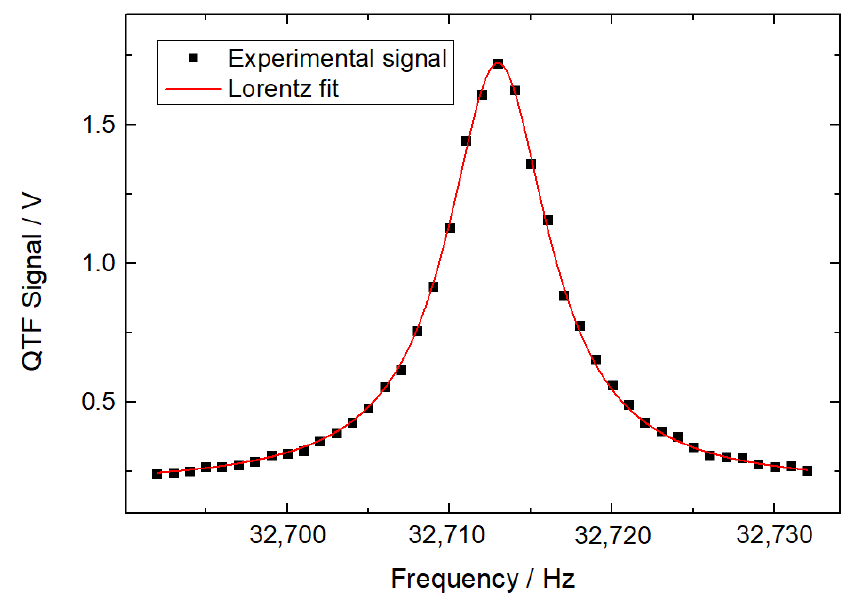
Figure 2. Frequency response of the QTF.